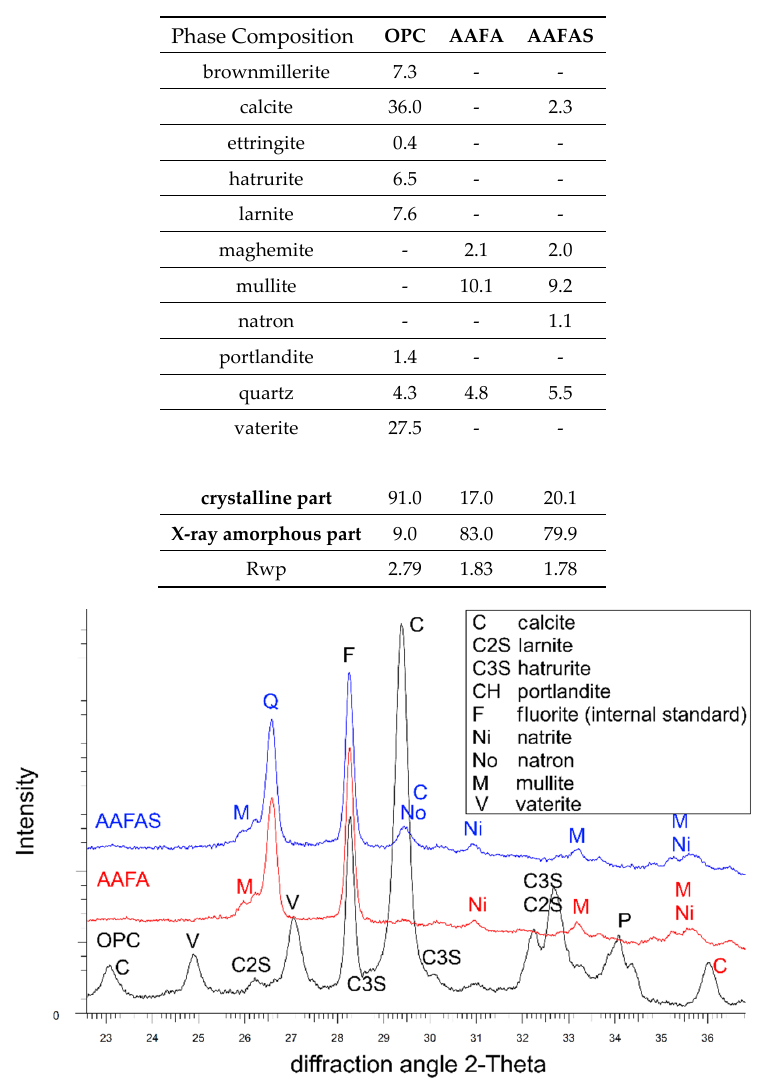
Figure 3. Phase composition (up) and diffraction patterns (down) of hardened binder pastes stored as powder (<125 µm) for 112 days (20 °C/ 65% rH/0.04% CO 2 ). On the other hand, the pH value of the eluates produced from concrete samples depends on the distance from the sample surface (Figure 4) and the CO 2 concentration (Figure 5).